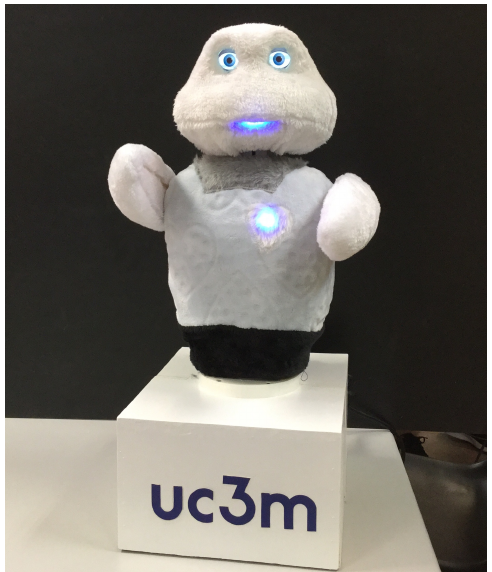
Figure 1. Mini, a social robot developed for interacting with older adults that suffer from mild cases of cognitive